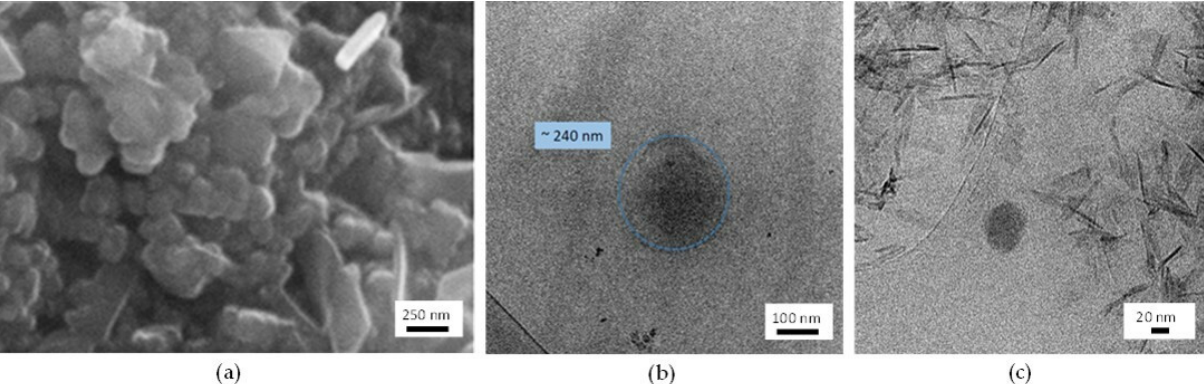
Figure 2. SEM micrographs of ( a ) CaP-NP POS 2A-3 and TEM micrographs of ( b ) NP POS 2 and ( c ) CaP-NP POS 2A-3. SEM image collected at 20 kV with the standard SE detector. Instrumental magnification: ( a ) 15,000 × , ( b ) 60,000 × , and ( c ) 50,000 × ,